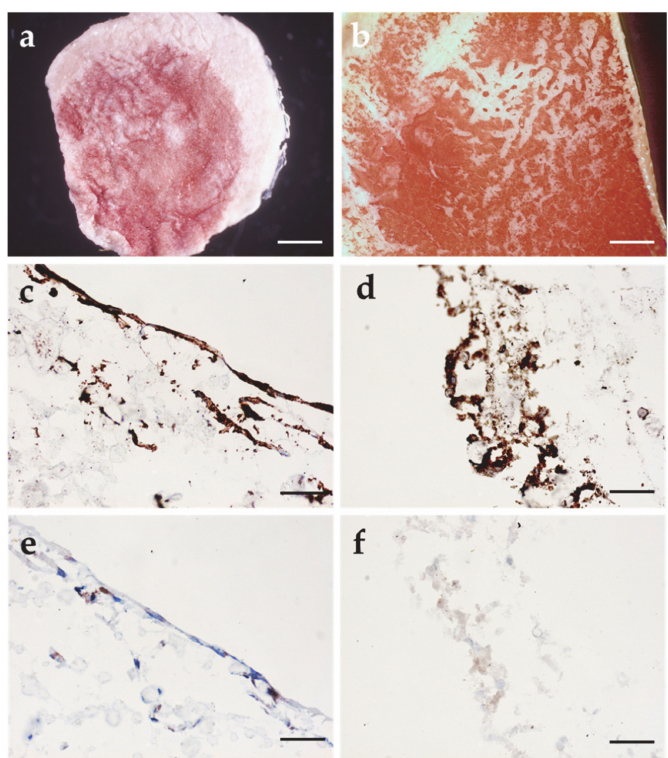
Figure 8. Neutral red assay and immunohistochemical analysis to detect fibroblast surface marker and collage type II on hMSC / HA / *PCL constructs: ( a , c , e ) statically di ff erentiated; and, ( b , d , f ) dynamically di ff erentiated. ( a , b ) Neutral red assay; viable cells are in red; ( c – f ) immunohistochemical analysis for: ( c , d ) fibroblast surface marker; and ( e , f ) collagen type II. Scale bars: ( a , b ) 1.2 mm; ( c – f ) 50 µ m and original magnification 400 ×